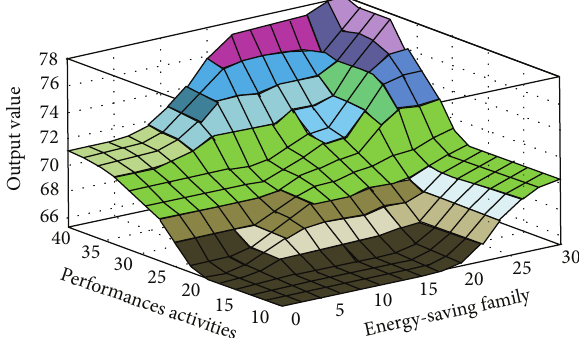
Figure 6: Input and output 3D mapping (energy-saving public facility and energy-saving